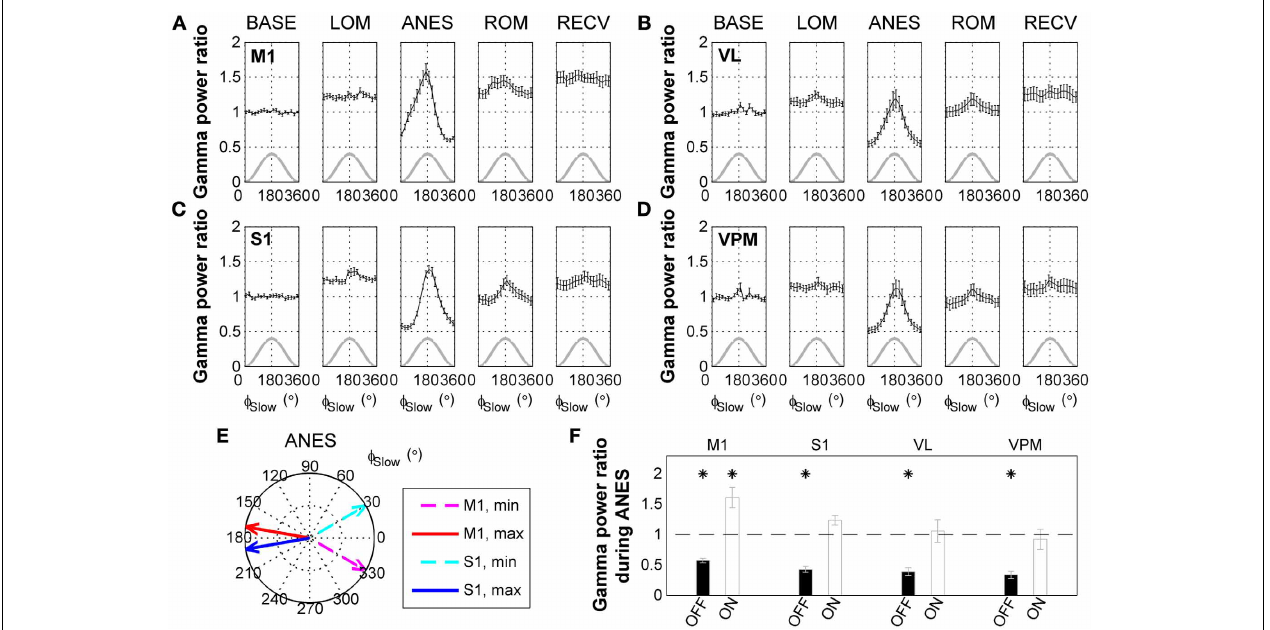
FIGURE 3 | State-dependent modulation of gamma activity during ketamine/xylazine anesthesia. Modulation of gamma (30–50Hz) activity by the phase of slow wave activity (0.5–4Hz) at (A) M1, (B) VL, (C) S1, and (D) VPM across ketamine/xylazine anesthesia. Gamma power is normalized to baseline level and drawn with respect to the phase of slow oscillation ( φ Slow ). Gray lines for corresponding slow oscillation. Error bars, mean ± s.e.m. Gamma power is represented as a ratio to baseline gamma power level. (E) Different positions of maximal and minimal gamma activities between M1 and S1 cortical regions during ANES period. Arrows in polar coordinates indicate the phases of slow oscillation at which gamma power reaches its minimum (dashed) and maximum (solid), respectively. Angular coordinate is the phase of slow oscillation